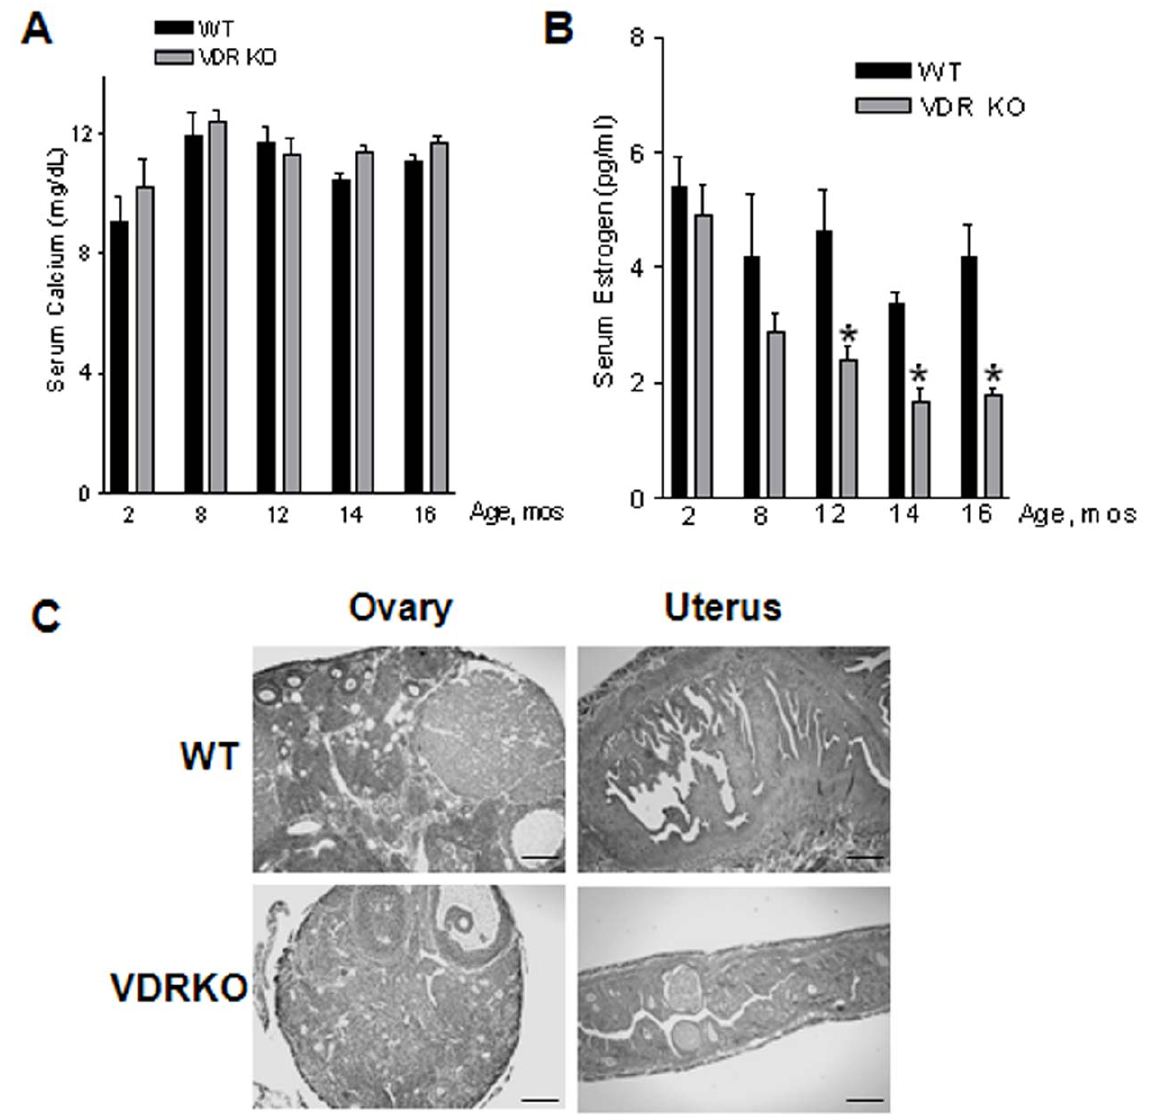
Figure 5. Effect of VDR ablation on serum calcium, estrogen, and estrogen responsive tissues in aging WT and VDR KO mice. A. Serum calcium levels in aging WT and VDR KO mice were equivalent prior to (2 and 8 months) and throughout the aging time course (12–16 months). B. Serum estrogen was measured by radioimmunoassay in WT and VDR KO mice at 2, 8, 12, 14, and 16 months of age. There was a significant reduction in serum estrogen by 12 months of age in the VDR KO mice that persisted through 16 months of age. *Statistically significant by Students t test, WT vs. VDR KO, n=8–10 p , 0.05. C. Representative hematoxylin and eosin Y stained sections of the ovary and the uterus, an estrogen responsive tissue. VDR KO tissues show signs of atrophy, likely due to incomplete follicle formation in the ovary and thus decreasing serum estrogen